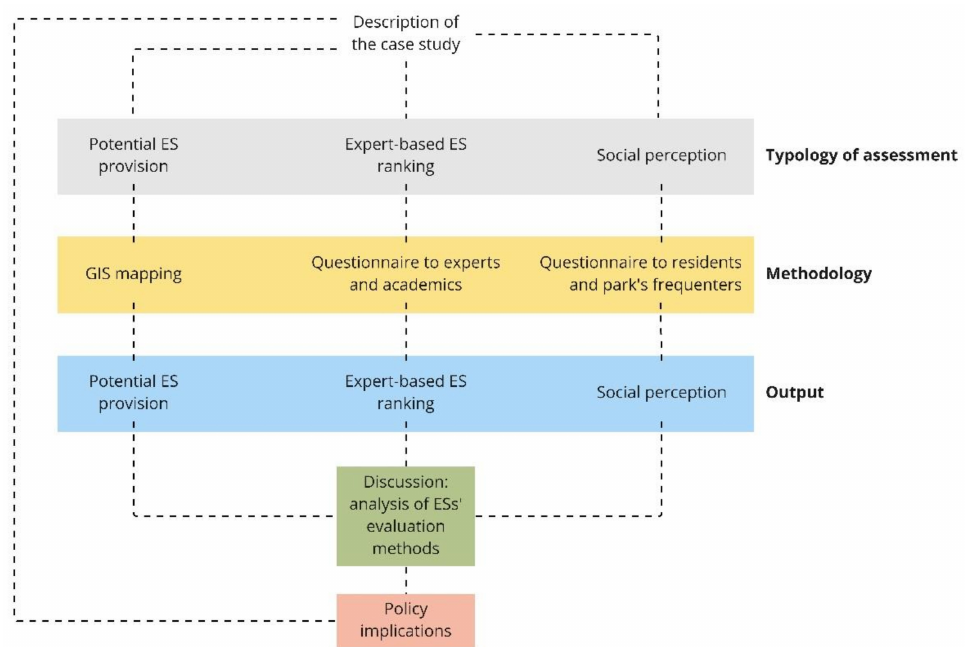
Figure 1. Research design (source: authors’